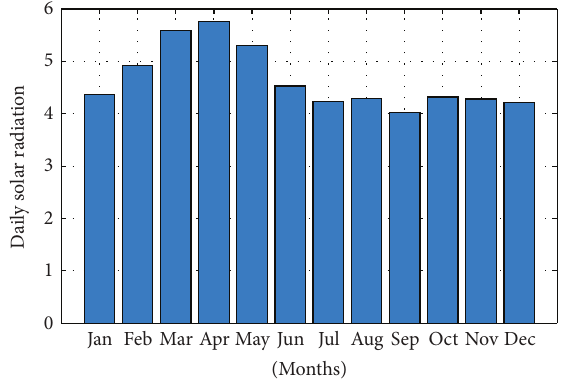
Figure 5: Monthly average daily solar radiation